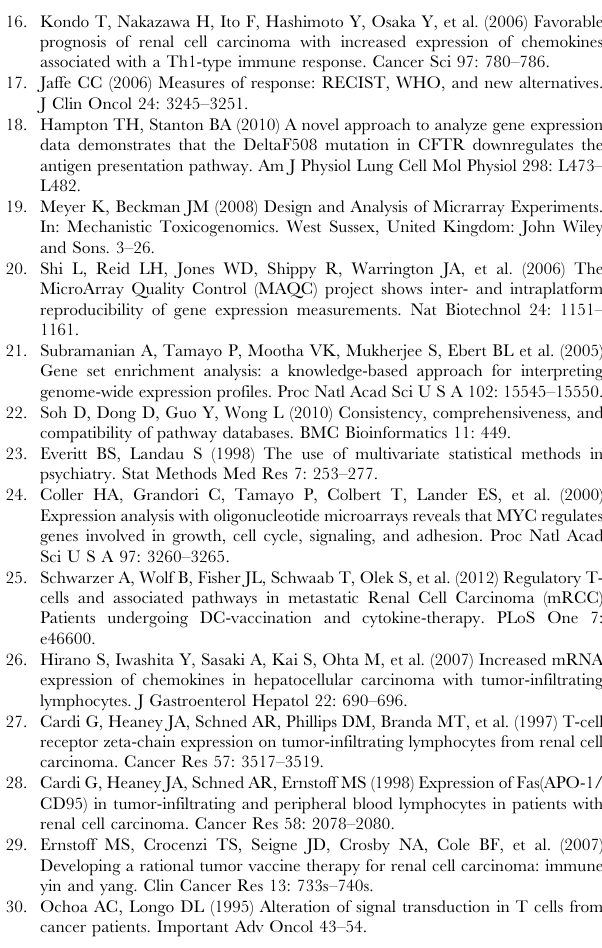
Figure S4 Comparison of treatment related changes in gene expression for responding versus non-responding patients (POST minus PRE) and analysis with IPA. Immune therapy leads to decreased expression of CTLA4 related genes in responding subjects. Figure S5 Peripheral blood serum concentrations for the cytokine Interferon inducible factor 10, IP-10 for healthy controls and mRCC patients PRE and POST treatment as a group and split based on response (n: 5 healthy controls, 8 mRCC: 4 R PRE, 4 NR PRE, 4 R POST, 4 NR POST). RCC patients show significantly higher levels of IP-10. Responders have higher levels of IP10 PRE (ns, p = 0.08). IP-10 serum levels increase with immune therapy in R and NR. This increase is significant for the patient group (p , 0.01) and for the smaller group of responding patients (p , 0.05). Figure S6 Correlation between the Fold Changes of 132 RCC-associated transcripts identified in PBMCs by Twine et al (1), and the corresponding fold change for our PBL based data set. The analysis revealed no similarities